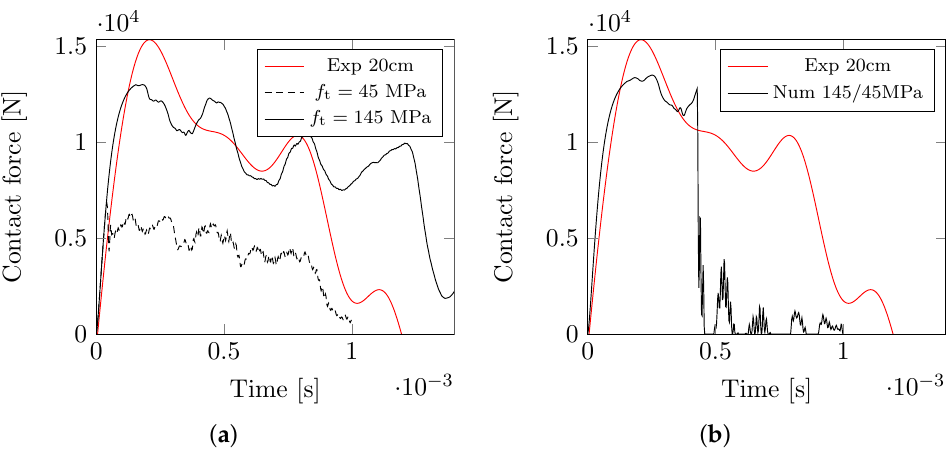
Figure 9. Comparison of evolution of measured and predicted contact force for destructive test: ( a ) constant tensile strength; ( b ) variable tensile strength.